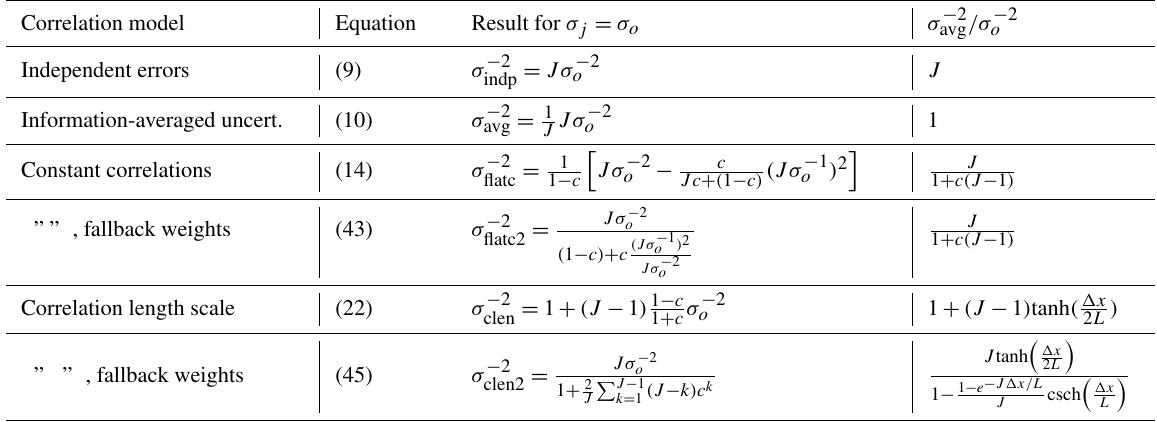
Table 2. The analytical expressions for the uncertainty on the average given by each correlation model for a simple case in which all measurement uncertainties have the same constant value, σ o .